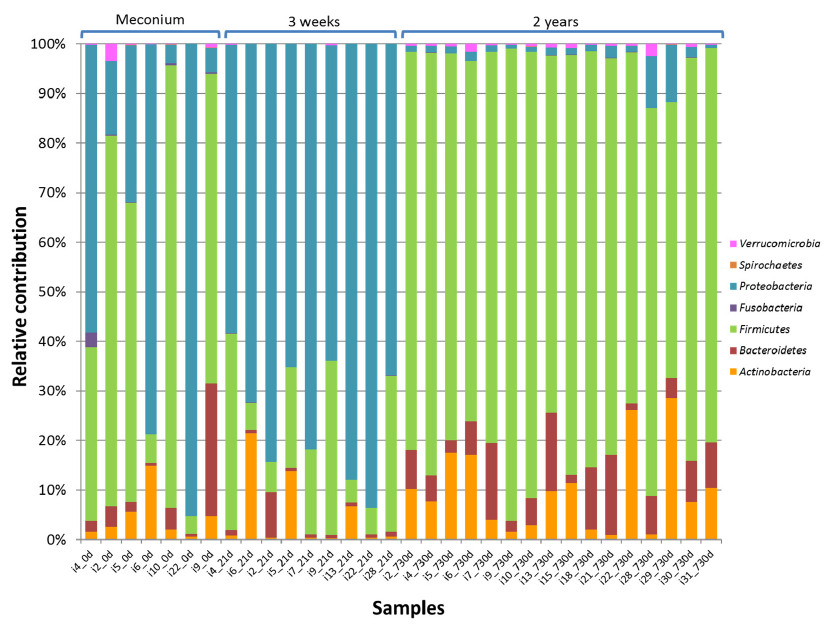
Figure 2. Development of the intestinal microbiota composition at the phylum level. The relative contribution is shown for the phyla detected in meconium, third week and 2 ‐ year fecal samples of the preterm infants.